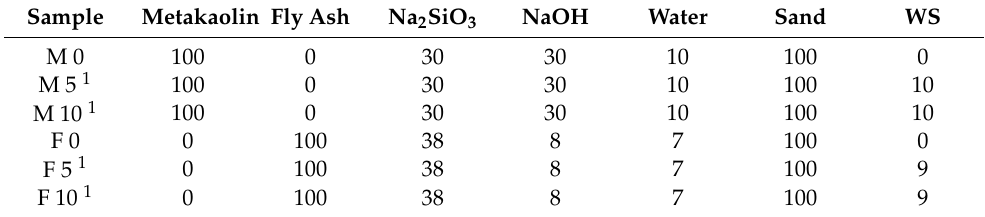
Table 1. Mortar composition (g) and